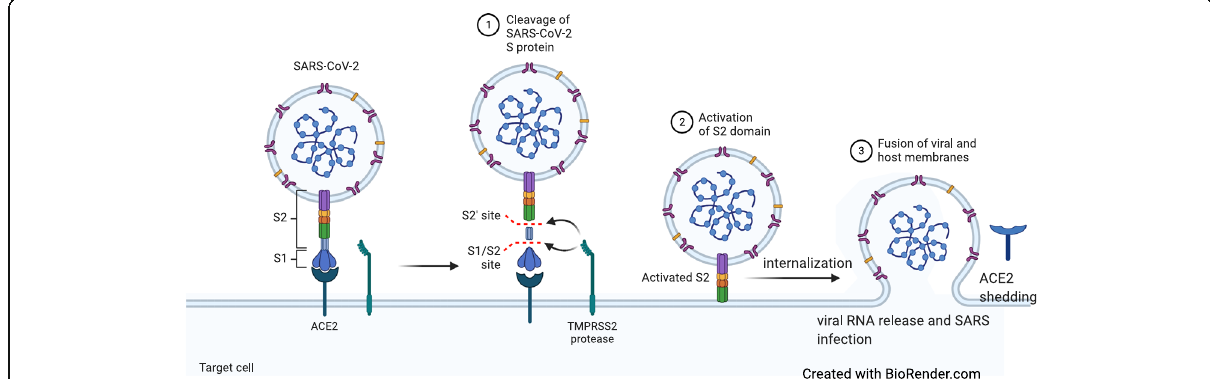
Fig. 2 Coronavirus uses angiotensin-converting enzyme-2 (ACE2) receptor to reach the cells with the binding of the viral spike (S) glycoprotein to cellular receptors via S protein priming by host cell proteases. TMPRSS2, transmembrane protease, serine 2; SARS-CoV-2, severe acute respiratory syndrome coronavirus